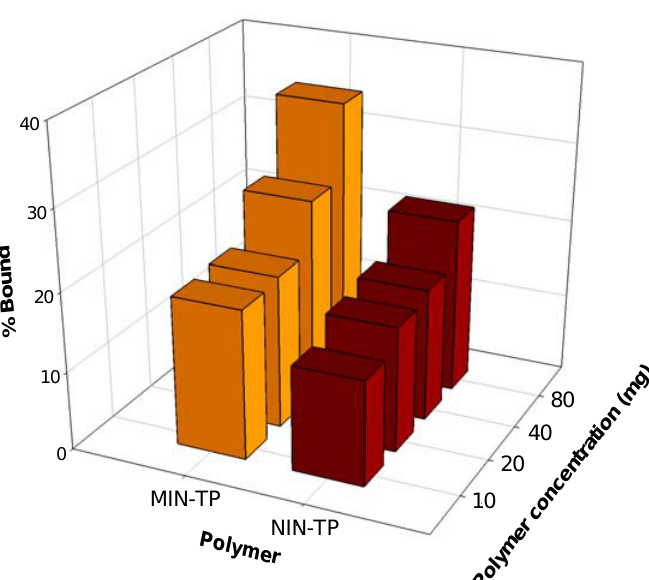
Figure 6. Rebinding analysis of TP-imprinted and non-imprinted nanospheres with